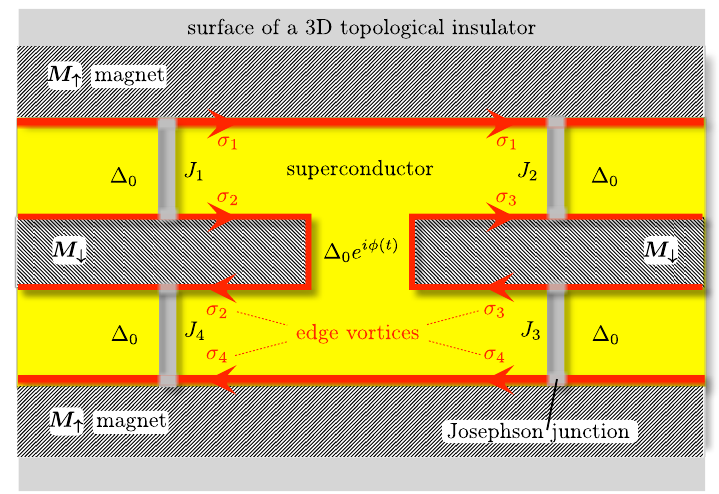
Figure 2: Geometry to create and fuse two pairs of edge vortices in a topological insulator / magnetic insulator / superconductor heterostructure. The edge vortices are created at Josephson junctions J and J , by a 2 π increment of the superconducting 1 3 phase φ ( t ) on the central superconducting island. Each edge vortex contains a Ma- jorana zero-mode and two zero-modes define a fermion parity qubit. The initial state | J 〉 = | 00 〉 has even-even fermion parity. When the edge vortices fuse at Josephson J (cid:112) 1 3 〉 = ( | 00 〉 + i | 11 〉 ) / J junctions J and J the final state | J 2 is in an equal-weight 2 4 2 4 superposition of even-even and odd-odd parity